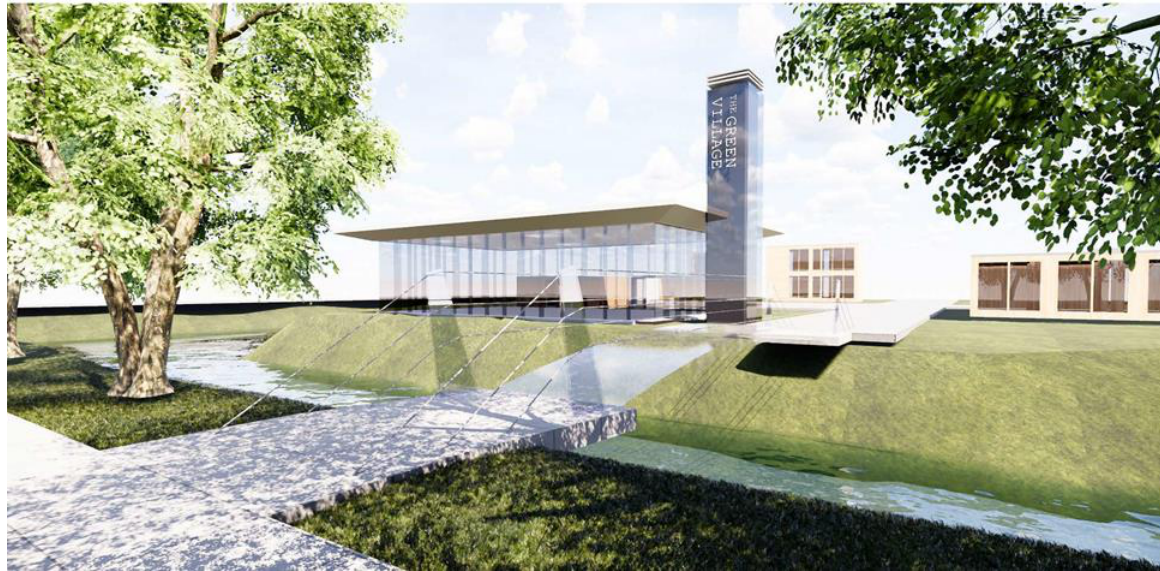
Fig. 2 3D impression of the optimized design (3D impression by Mecanoo,